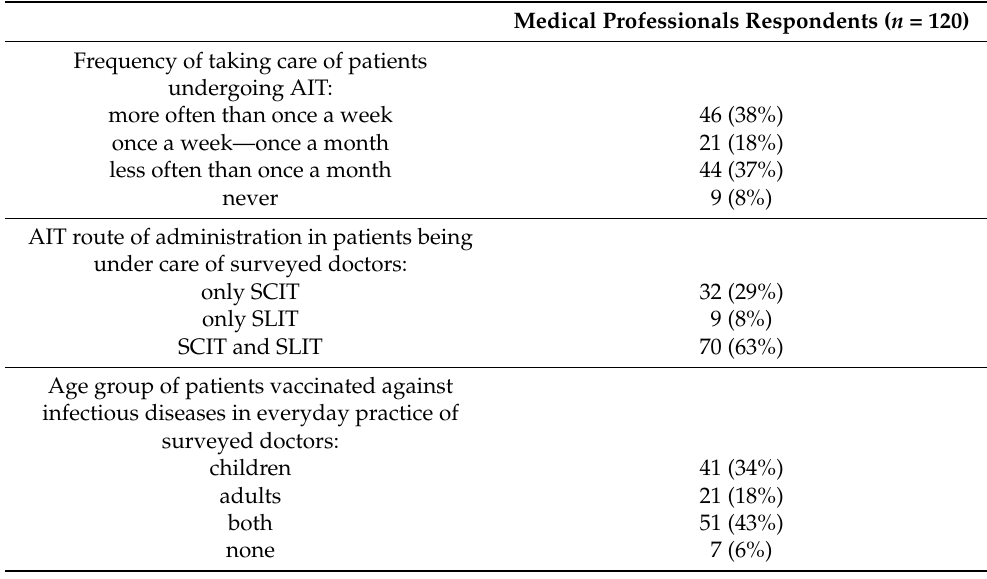
Table 5. General information regarding patients undergoing therapeutic (AIT) and prophylactic vaccinations that are under the care of the surveyed